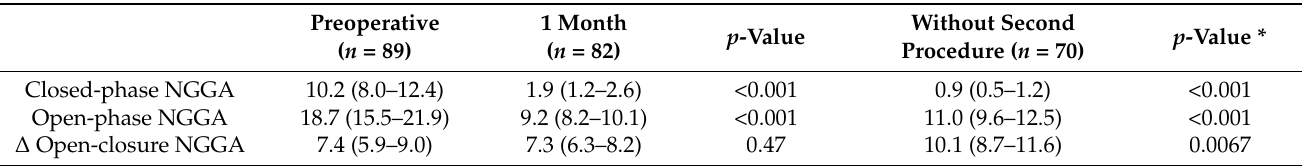
Table 2. Difference of laryngeal configuration before and one month after the EIL; difference of laryngeal configuration before the EIL and at last follow-up in patients without secondary procedures.